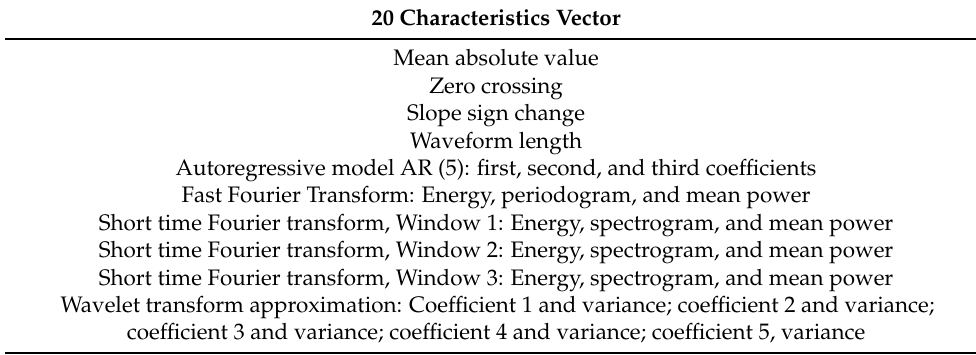
Table 1. EMG signal characteristics, for a hybrid vector of 20 times, frequency, and time-frequency.